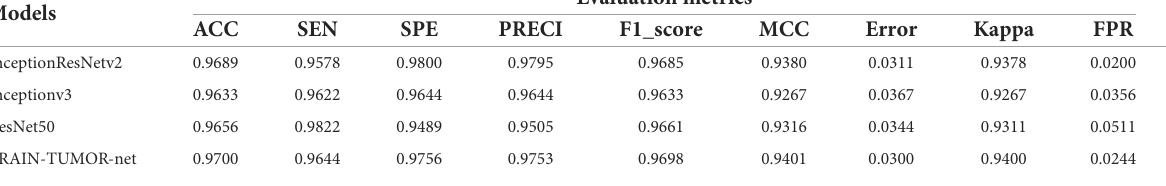
TABLE 2 Detection performance results for the proposed CNN models with a 75/25 training/testing ratio on the second dataset.